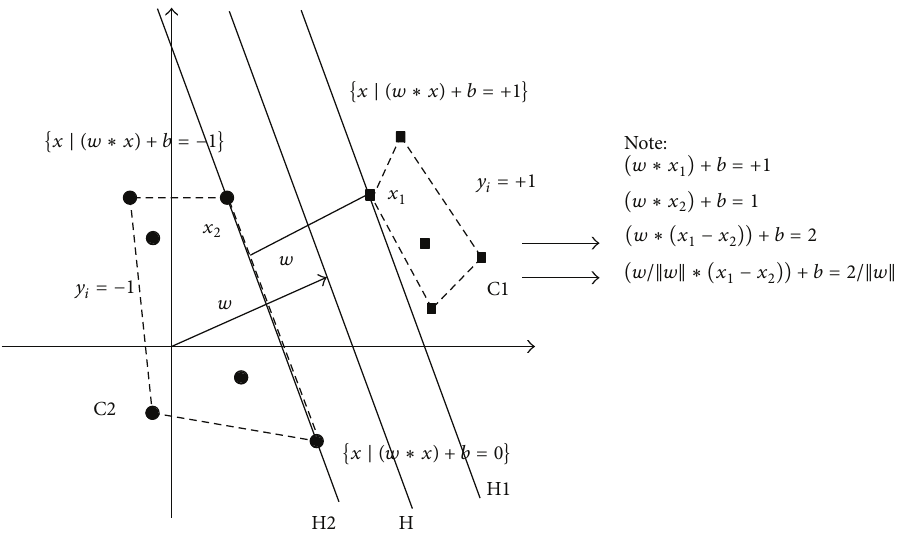
Figure 1: Theory of support vector machine.